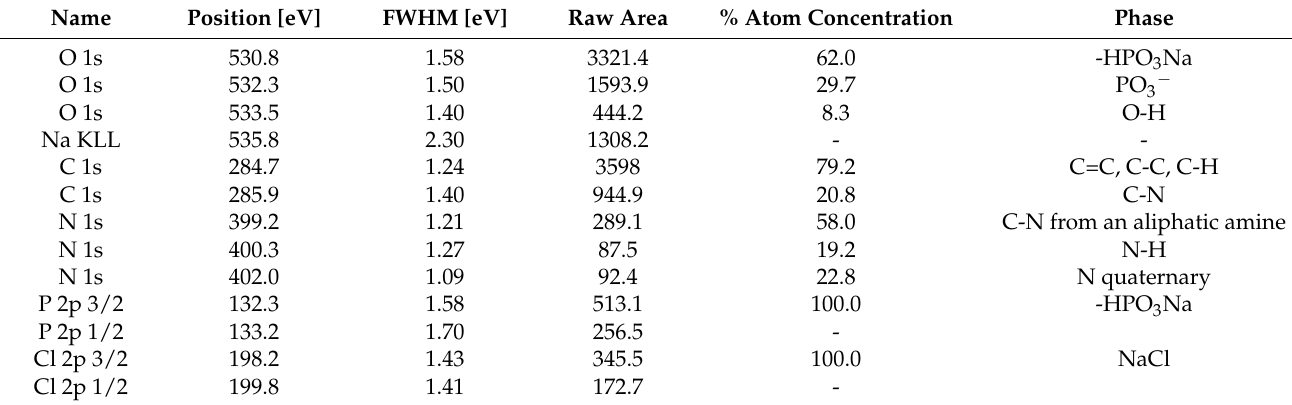
Table 3. The XPS analysis results obtained in the narrow range of binding energies for Purolite S